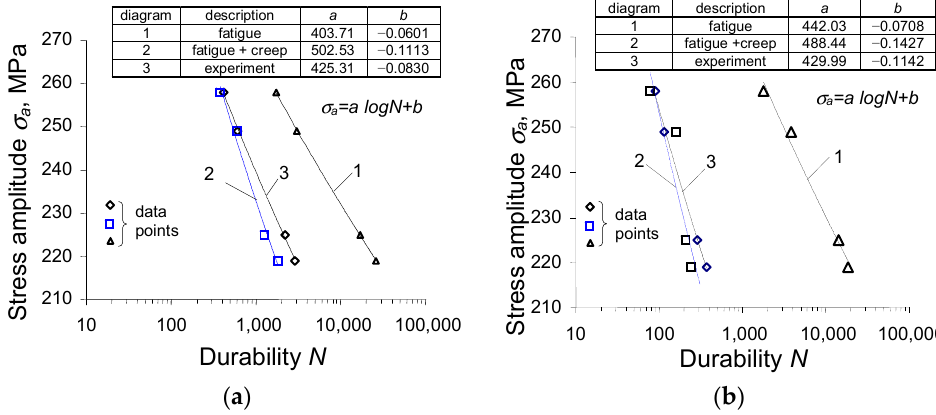
Figure 15. Durability diagrams (experimental and calculated): ( a ) 𝜏 = 5 s , ( b ) 𝜏 = 30 s .